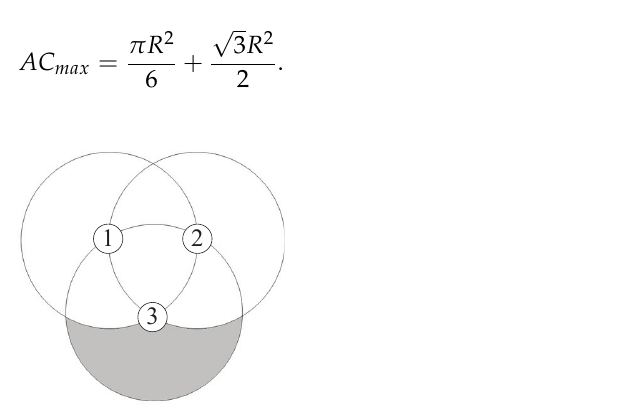
Figure 11. The maximum additional coverage area achieved by node